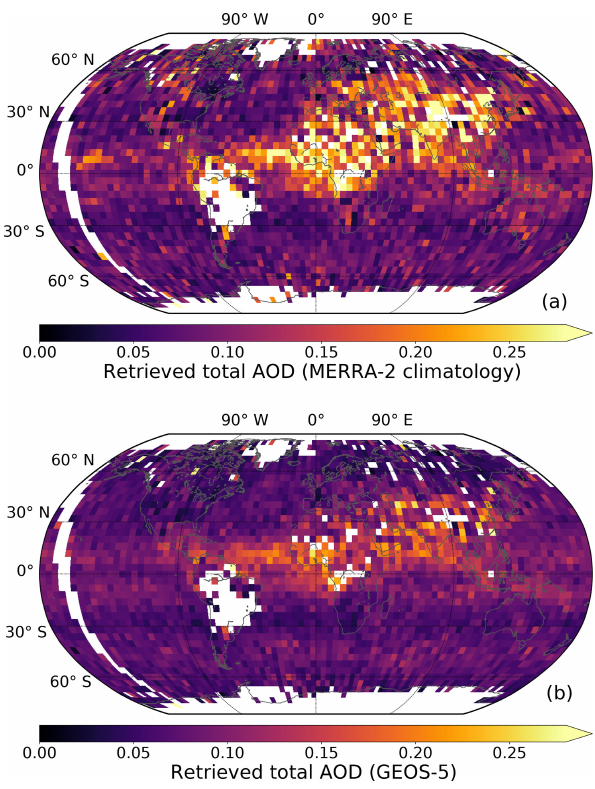
Figure 10. (a) The 4 ◦ × 4 ◦ binned retrieved AOD for V8. (b) The 4 ◦ × 4 ◦ binned retrieved AOD for V8 + GEOS-5 types and AODs with low uncertainty. White bins represent no data.